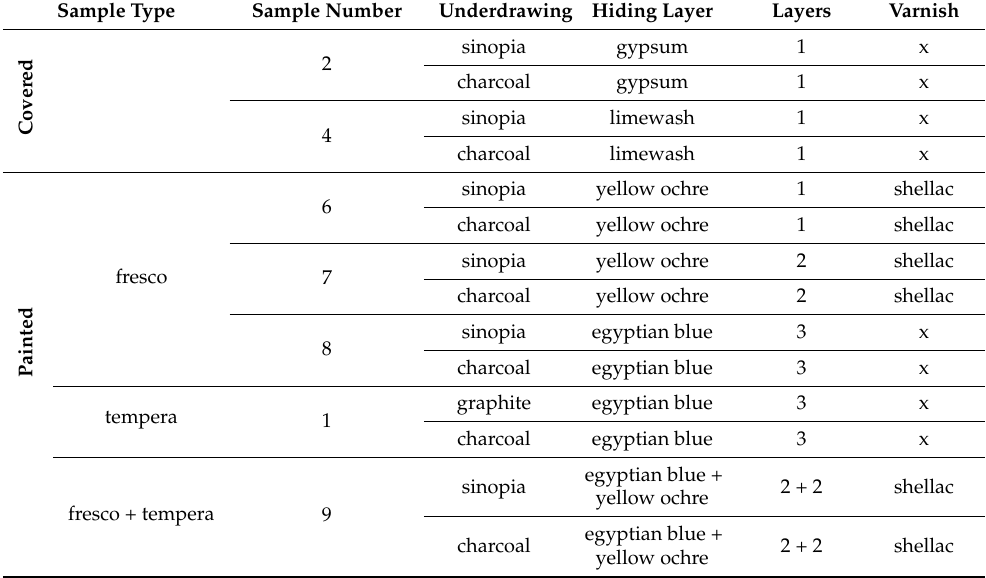
Table 1. Mock-up paint layer